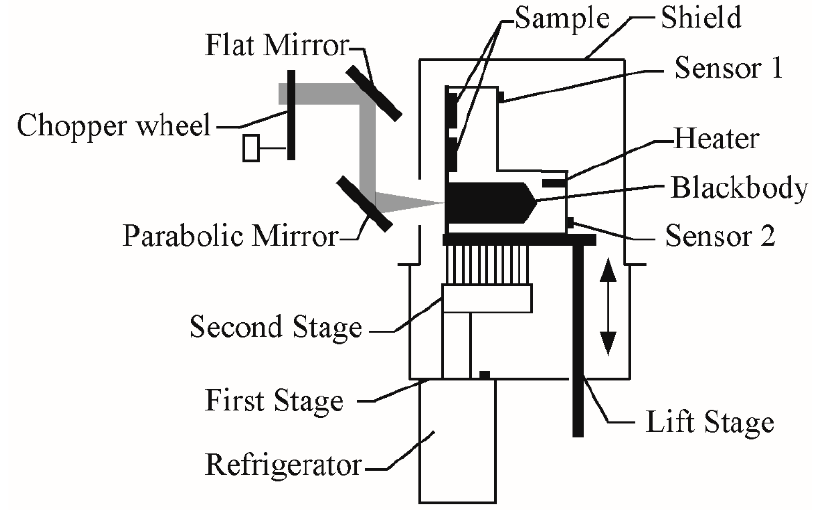
Figure 3. Schematic diagram of the sample cooling chamber.